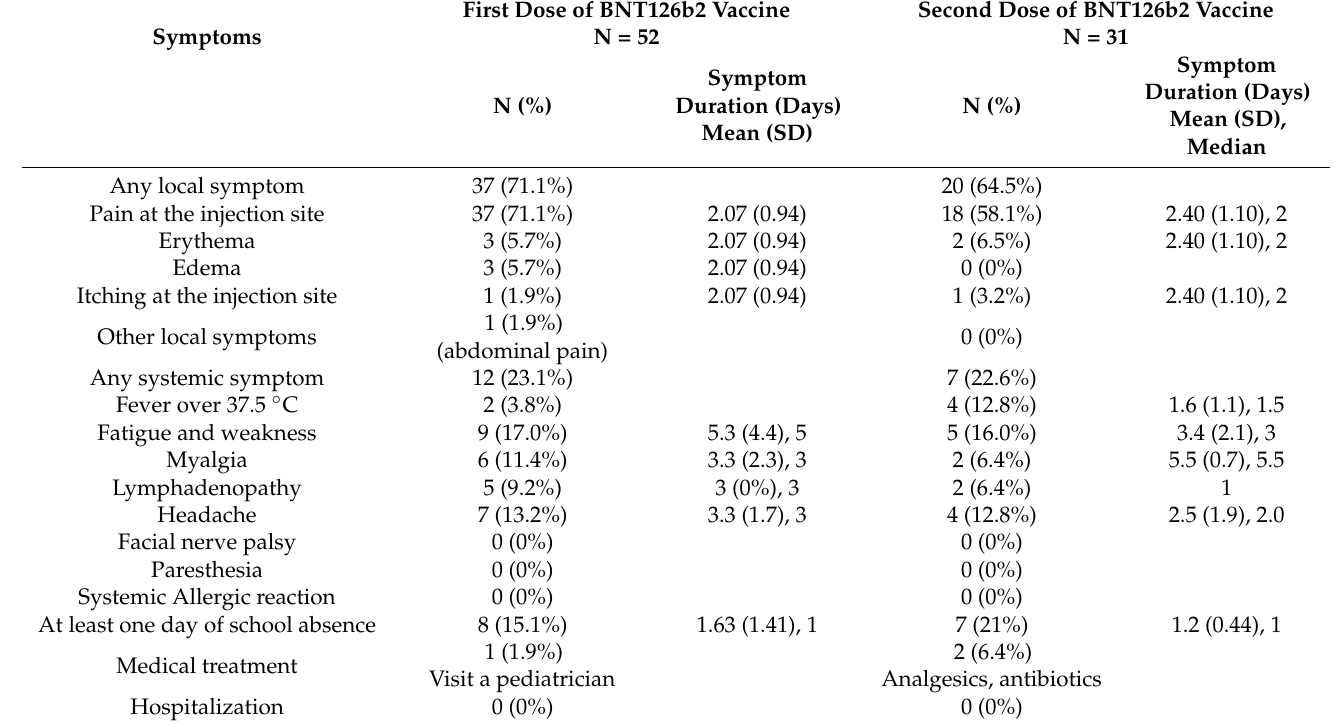
Table 3. Adverse events of first and second dose of BNT126b2 vaccine.